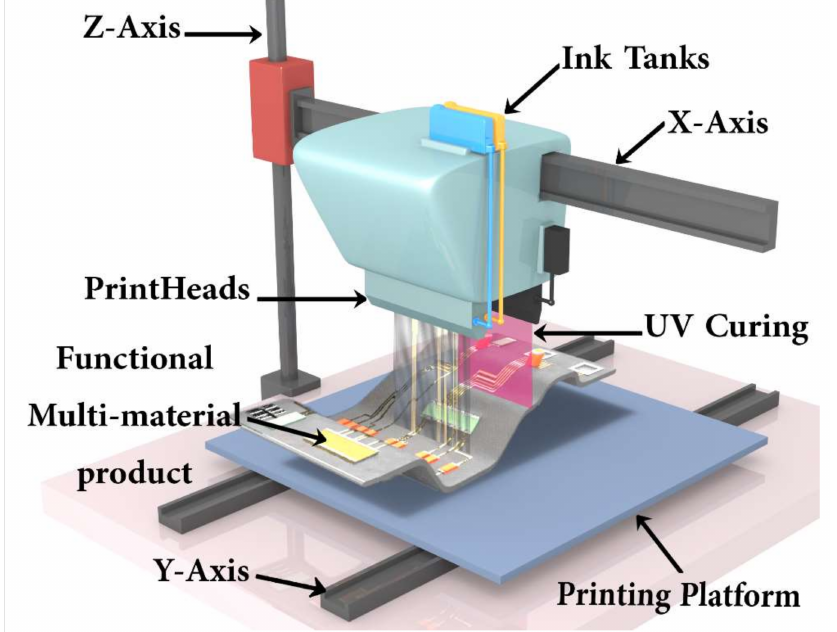
Figure 1. Schematic of the 3D inkjet printing